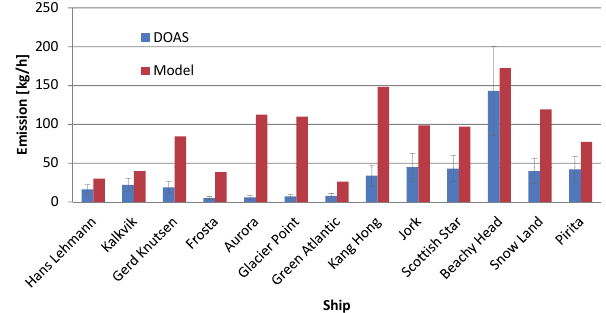
Fig. 15. Comparison of NO 2 and NO x emission rates obtained by optical measurements (DOAS) and the FMI-Steam model, respec- tively, for ships on the Baltic Sea during 2008. The measurement error bars correspond to 40% uncertainty.